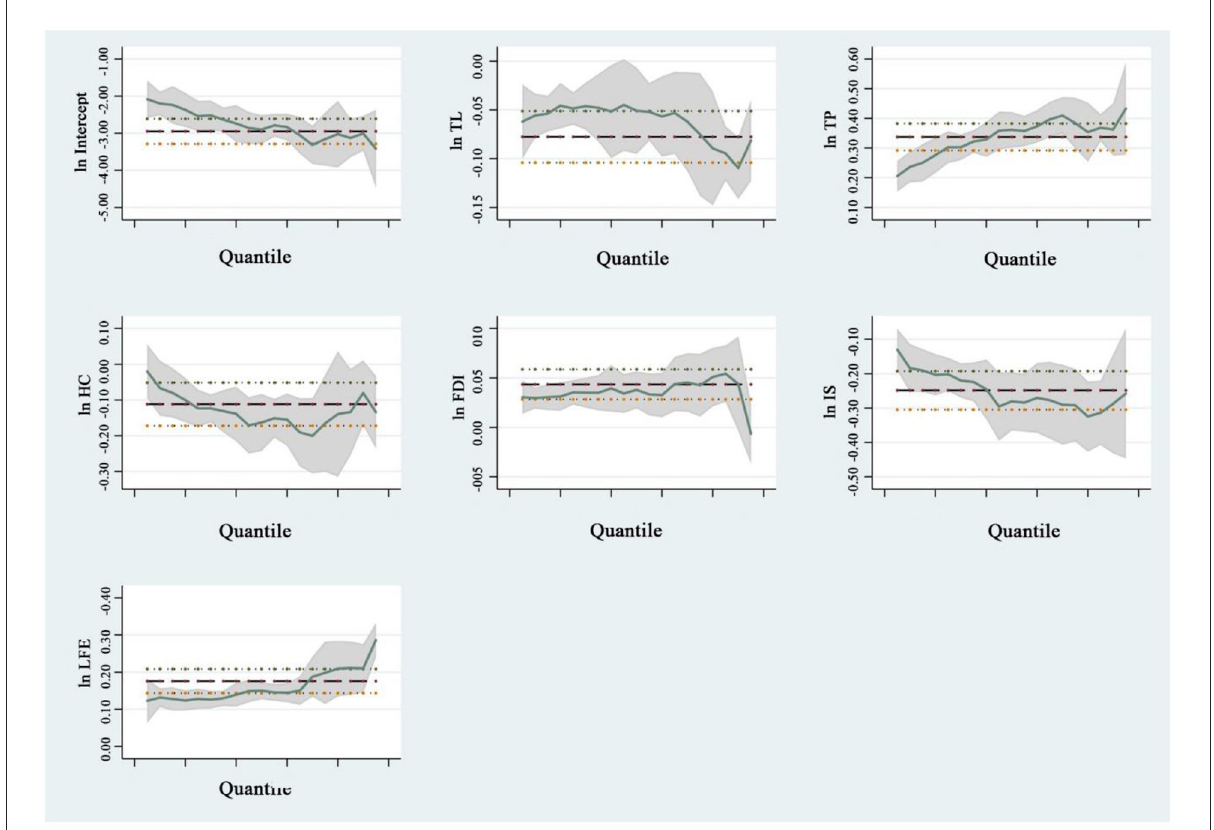
FIGURE5 Distribution of the regression elasticity coefficient of influencing factors of the environmental pollution index (EP) in